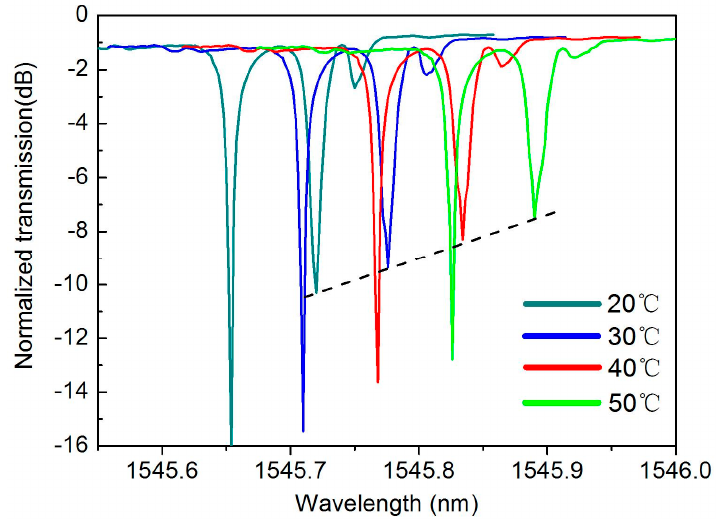
Figure 8. The response of transparency window in different temperatures.